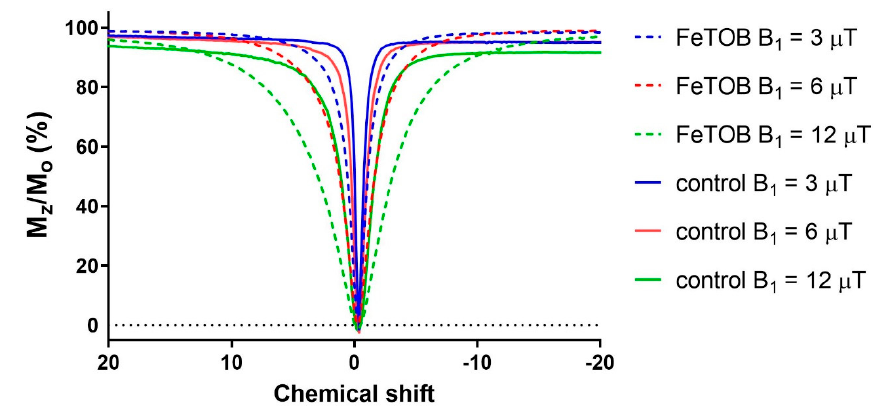
Figure 1. Z-spectra of the control (solid line) and 10 mM Fe(TOB)-labeled (dashed line) cells using endocytosis in S. cerevisiae in 1× PBS at 37 °C.